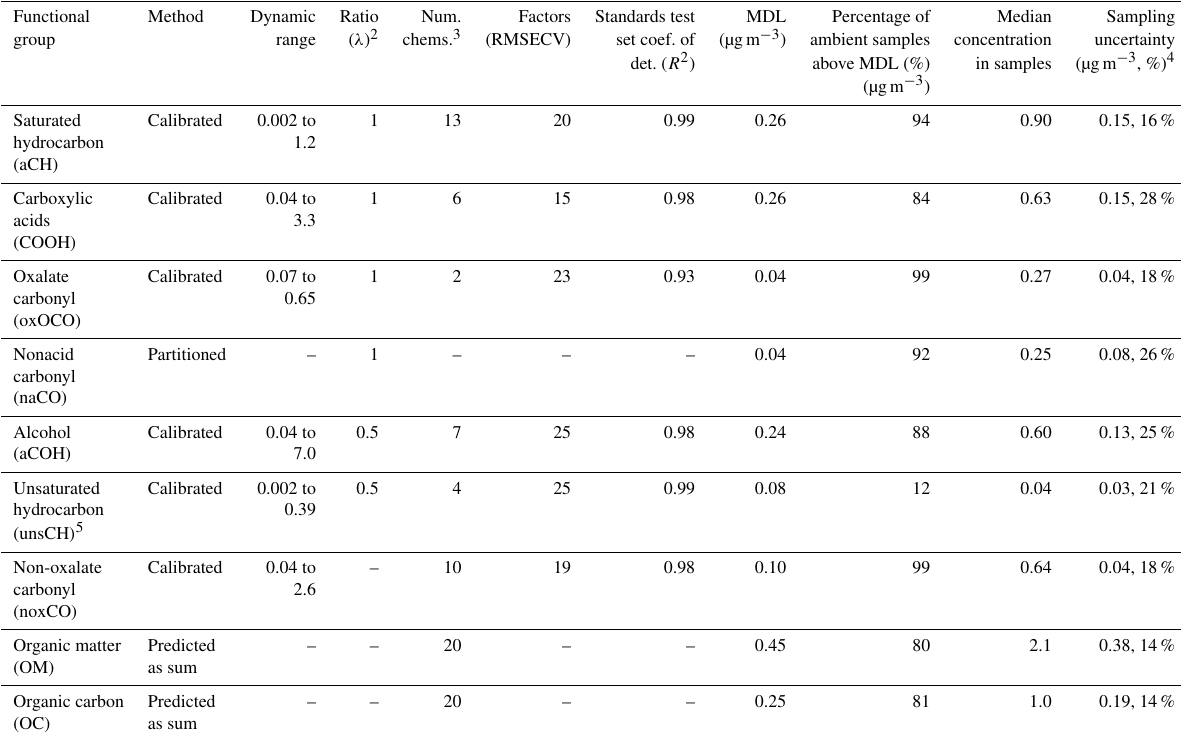
Table 2. Summary of calibration model parameters and outputs. Functional groups calibrated but not reported in the final models are also included, below the first horizontal